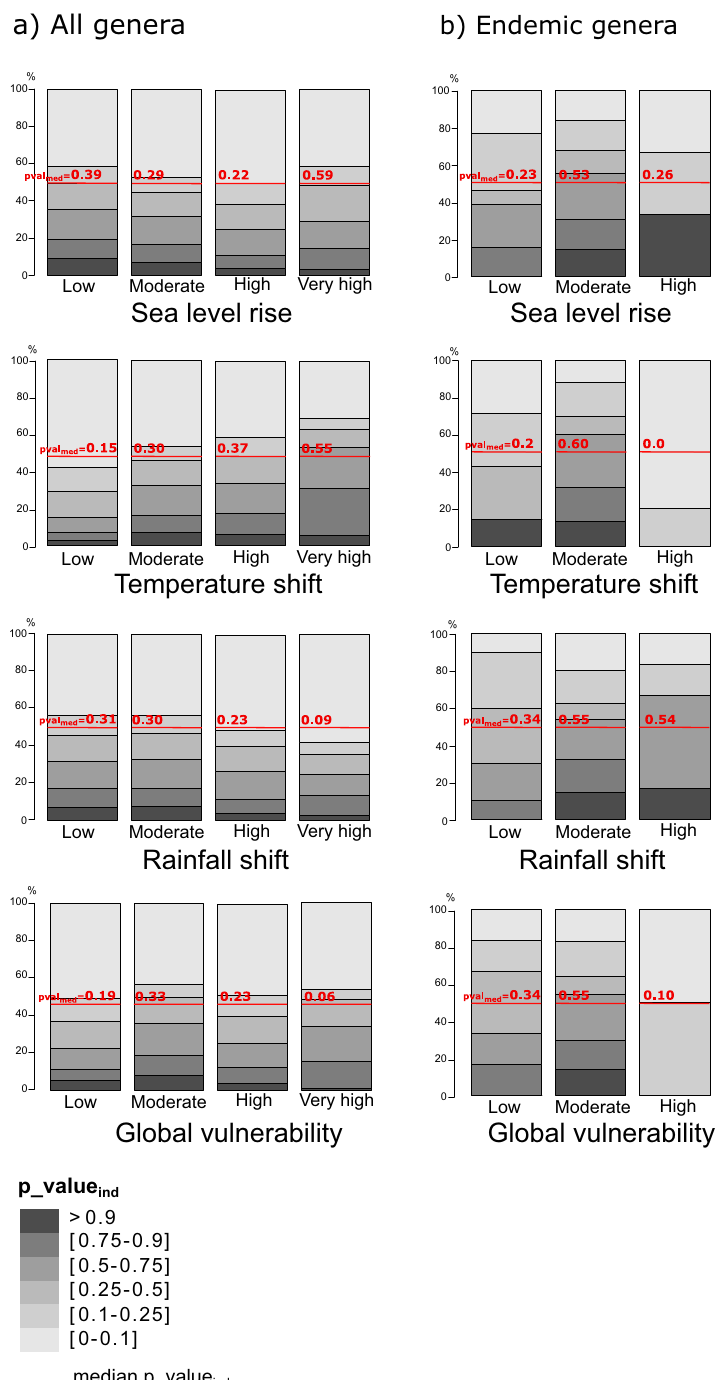
Figure 5. Distribution of p_value ind frequencies for each vulnerability category and type of threat. 50% of p_values ind are higher than the median p_value ind and 50% are